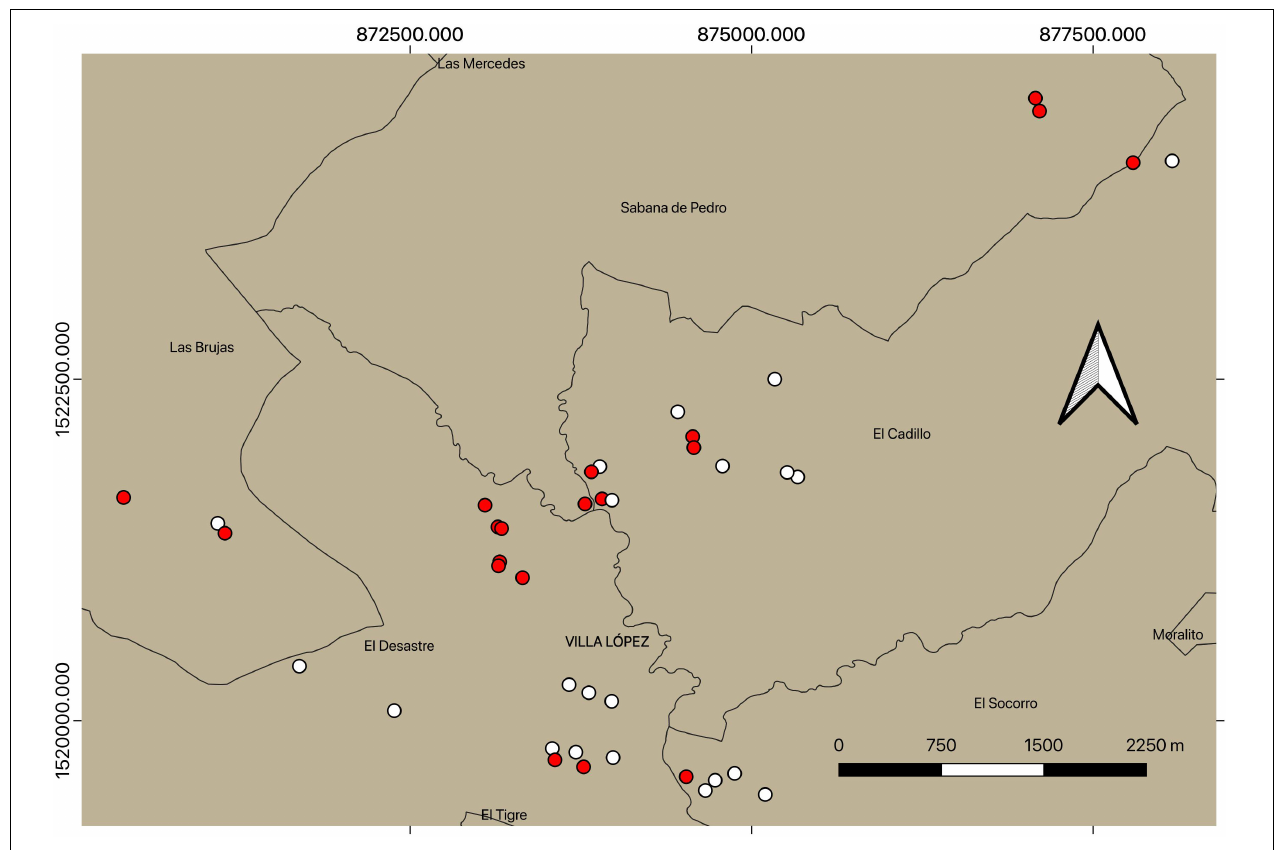
FIGURE 4 | Distribution map of the 40 cassava fields sampled in Villa López and infected by Cassava Bacterial Blight. Fields infected with CBB are depicted in red ( n = 19), and uninfected fields appear in white ( n = 21). WGS